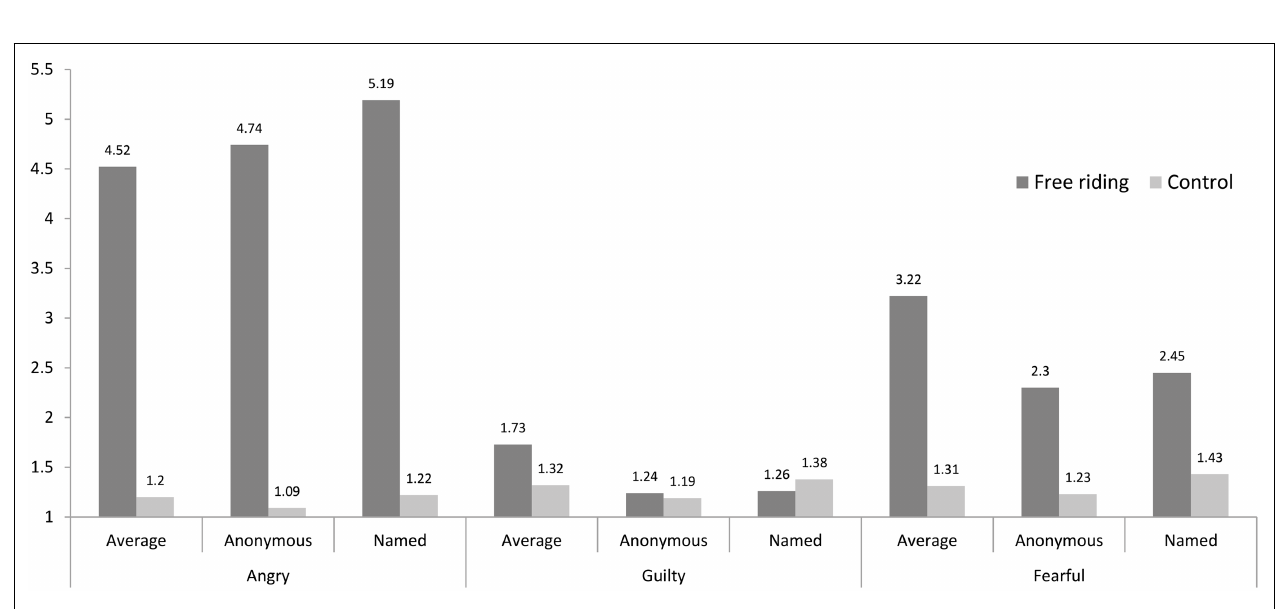
FIGURE 3 | Effects of scenarios and display types on feelings of anger, guilt, and fear